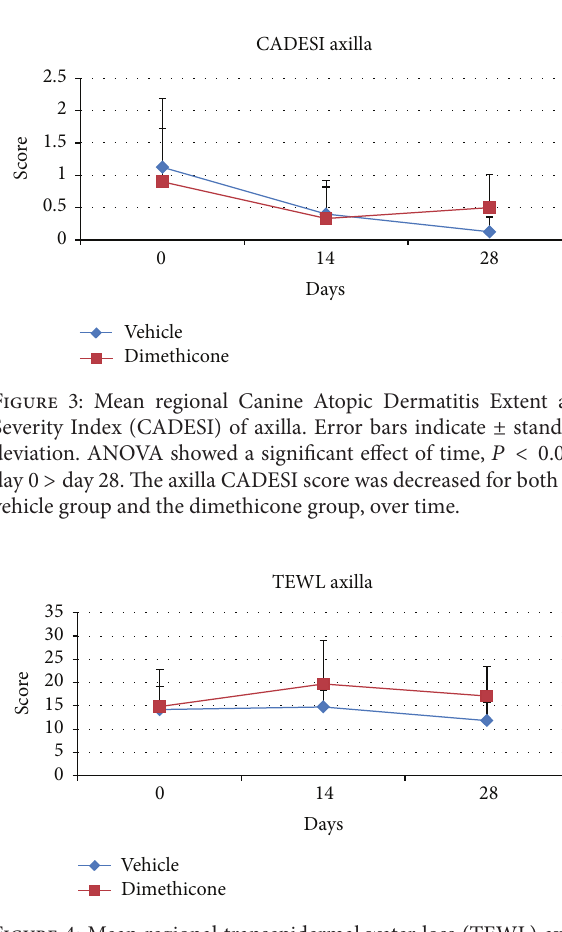
Figure 4: Mean regional transepidermal water loss (TEWL) axilla scores. Error bars indicate ± standard deviation. ANOVA showed a significant effect of time ( 𝑃 < 0.005 ), with day 0 > day 28. In the vehicle group the axilla TEWL score was slightly decreased while in the dimethicone group there was an increase over time of the